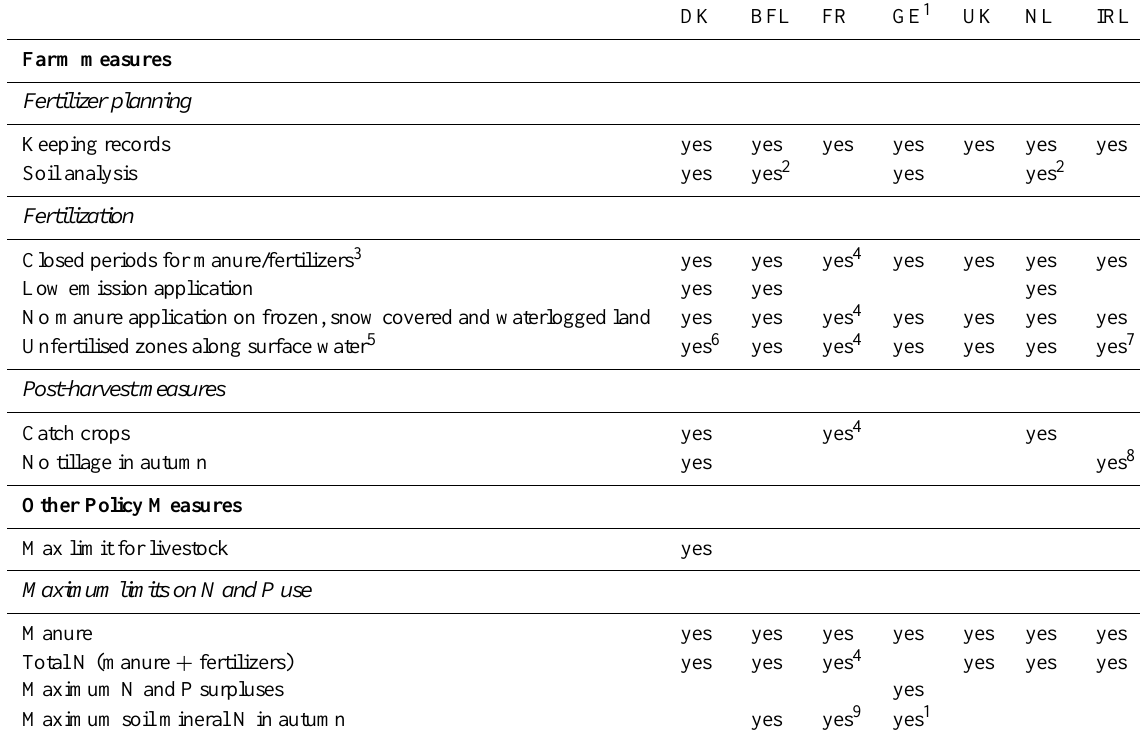
Table 6. Restrictions for application of fertilizer and manure in national implementations of the Nitrates Directive (Adapted from Dijk and Berge,